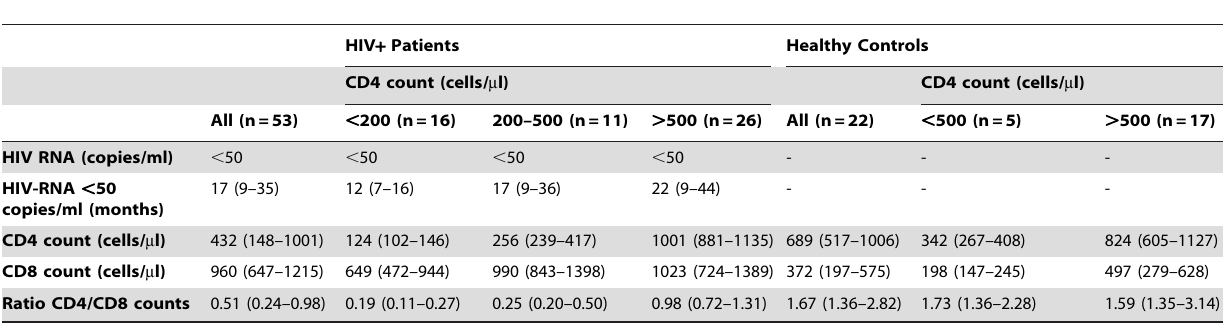
Table 2. Characteristics of cross-sectional data participants.